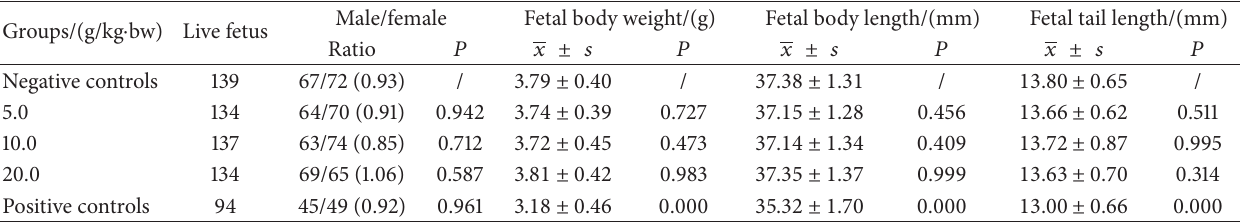
Table 7: Effect of C. paliurus leaf aqueous extract on sexuality, fetal body weight, body length, and tail length of fetal rat. Data are expressed as mean ± SD.